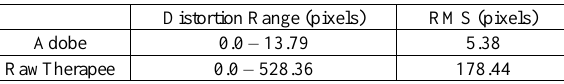
Table 3. Distortion statistics for Camera Calibration